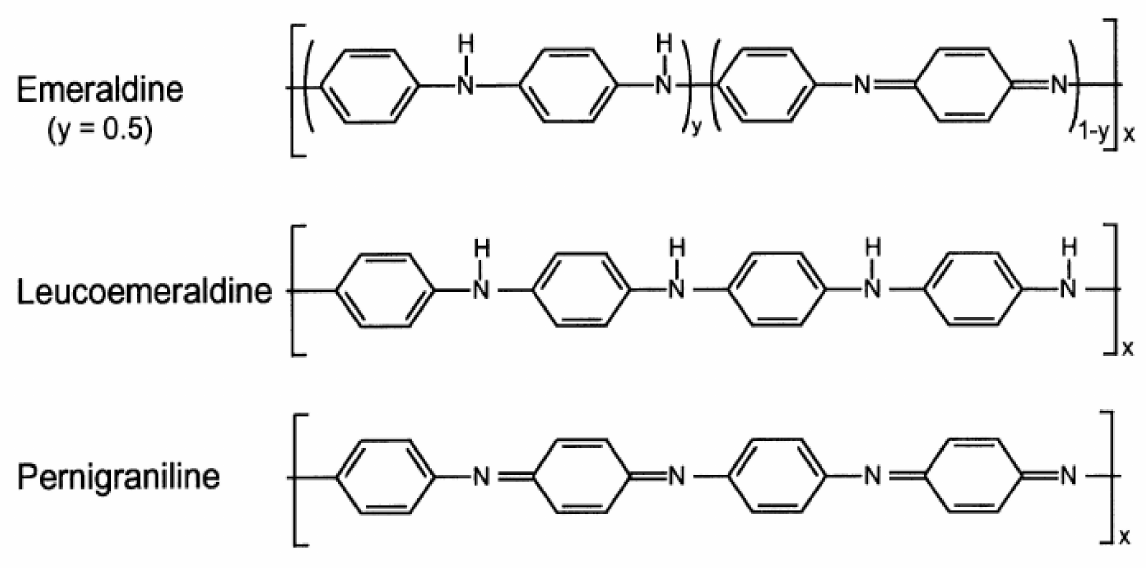
Figure 1. Structures of polyaniline at different oxidation